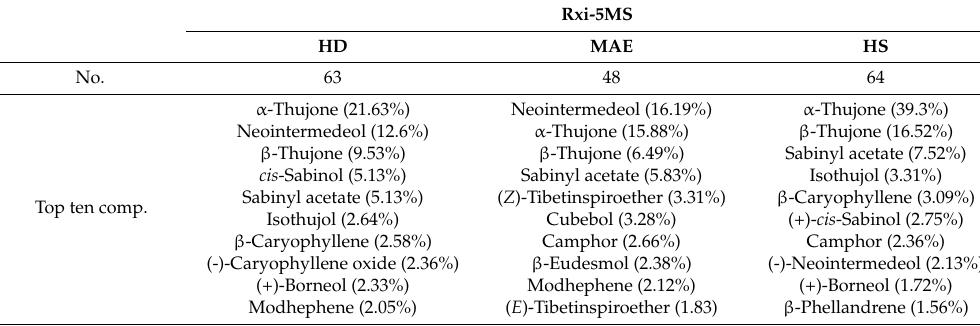
Table 1. Top ten constituents identified in essential oil obtained with three extraction methods and analyzed on two columns.